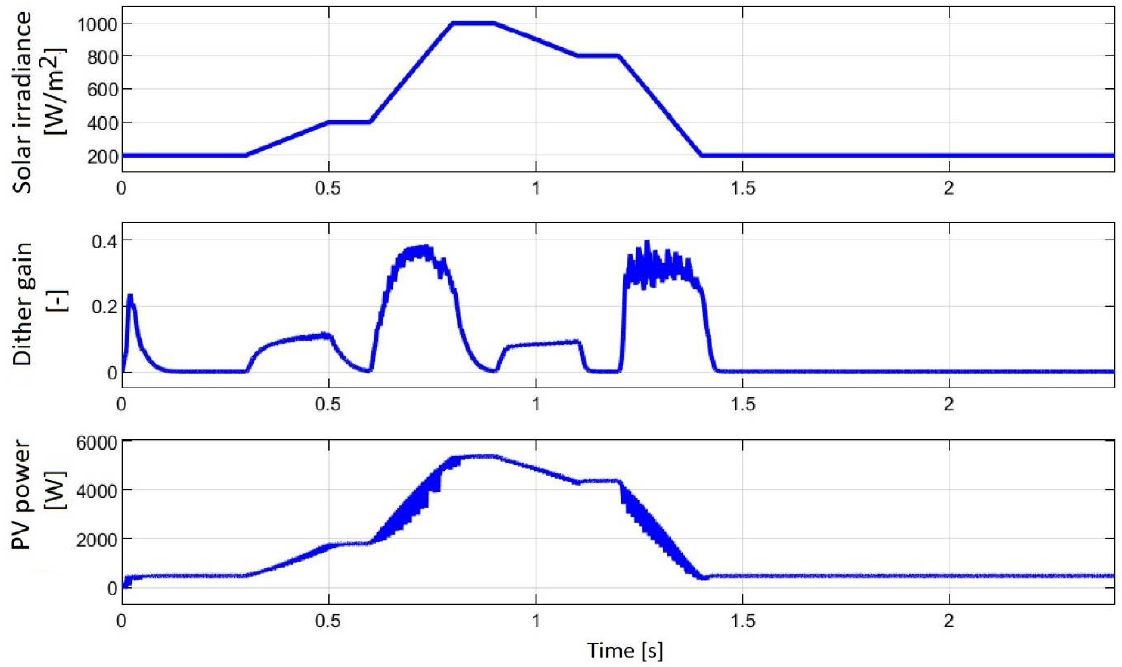
Figure 5. PV/ESS system under variable solar irradiance profile with slow slopes.